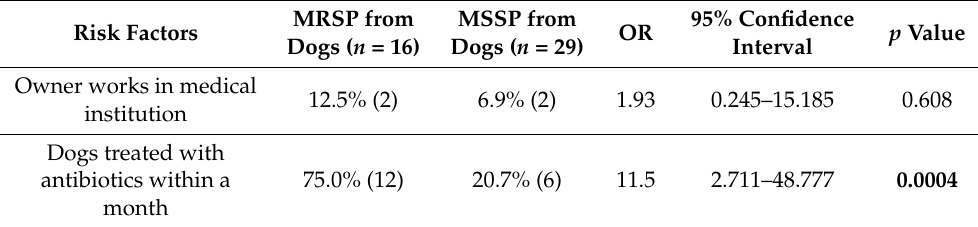
Table 5. Risk factors analysis of MRSP and MSSP from dogs.